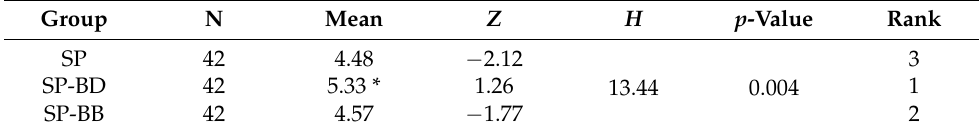
Table 2. Quantitative descriptive sensory analysis using the preference scale